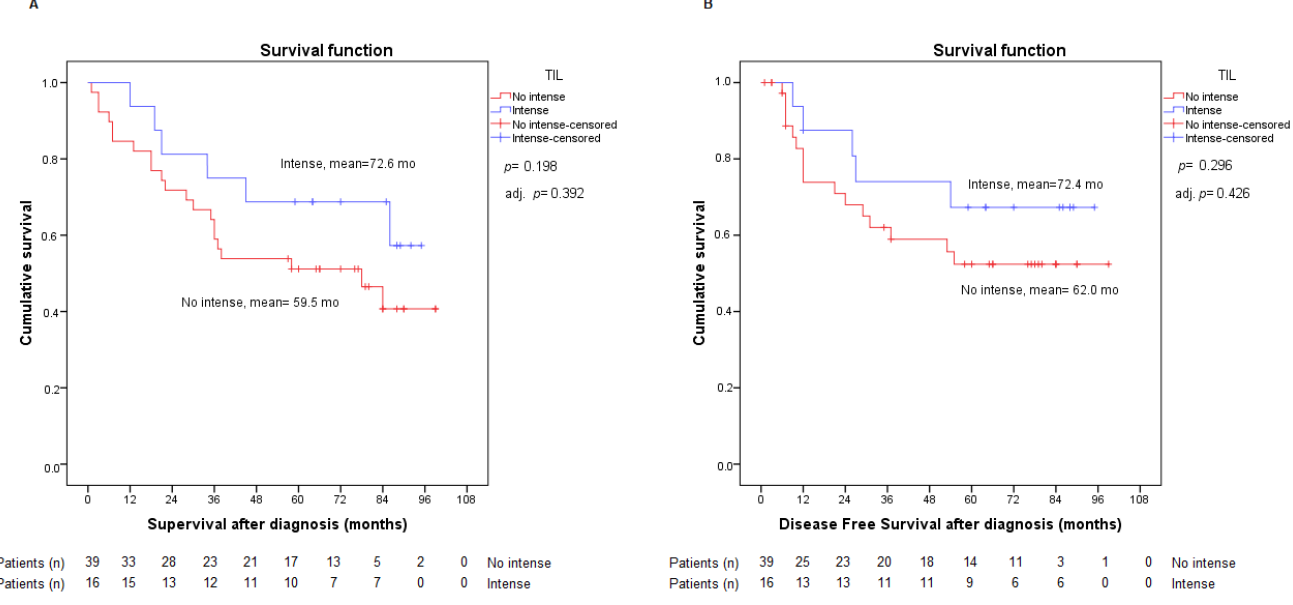
Figure 3. Analysis of overall survival ( A ) and disease-free survival ( B ) according to intense or non-intense TIL expression. Adj. p : p -value from Cox regression model adjusted by stage.